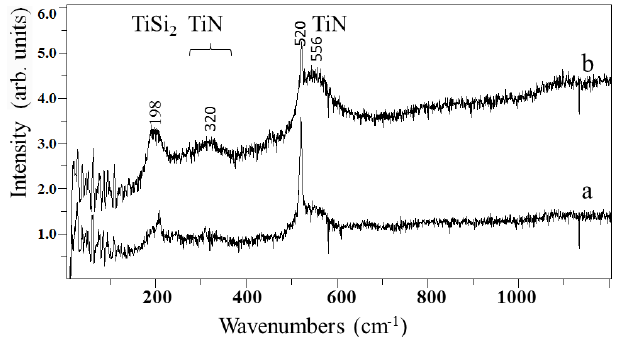
Figure 8. Raman scattering spectra of Ti films, 250 nm thick, heated at 800 °C and processed in (Ar ‐ 33%N 2 ‐ 1%H 2 ) plasma for 30 min ( a ) and 3 h ( b ).